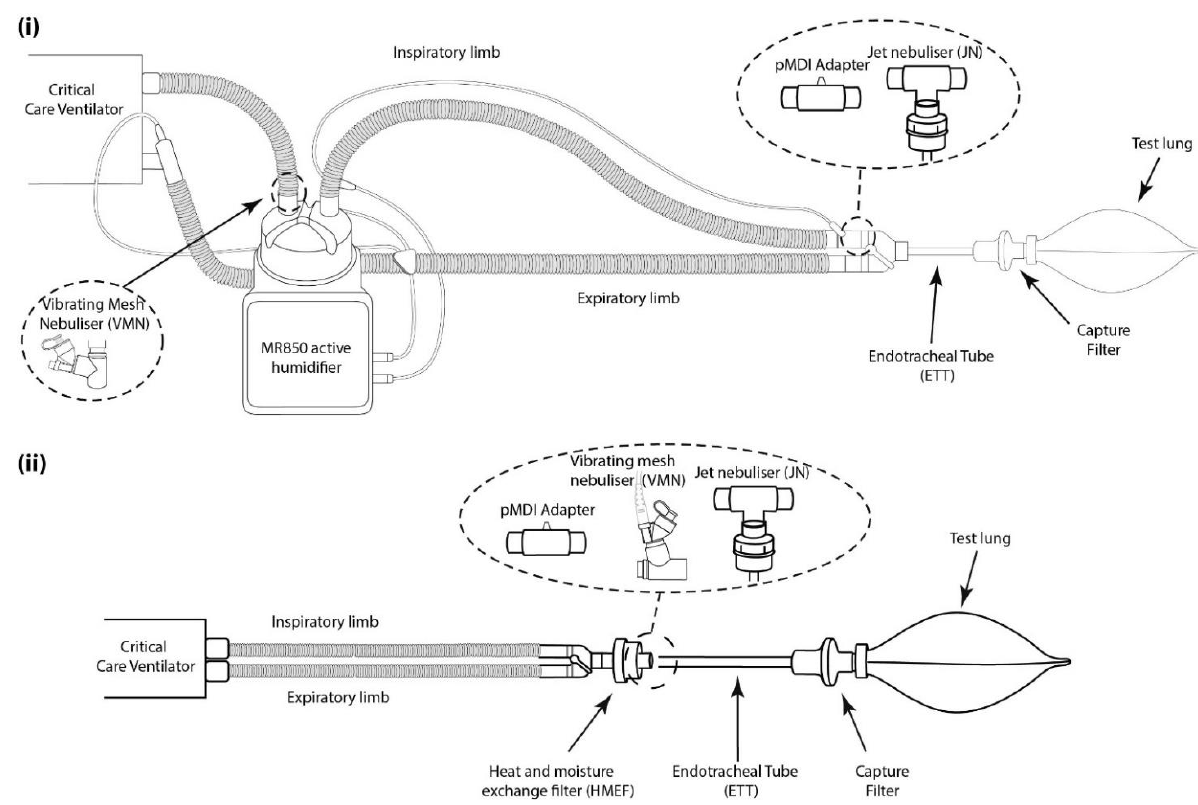
Figure 2. Illustration of simulated mechanical ventilation setup with ( i ) active humidification and ( ii ) passive humidifica- tion.